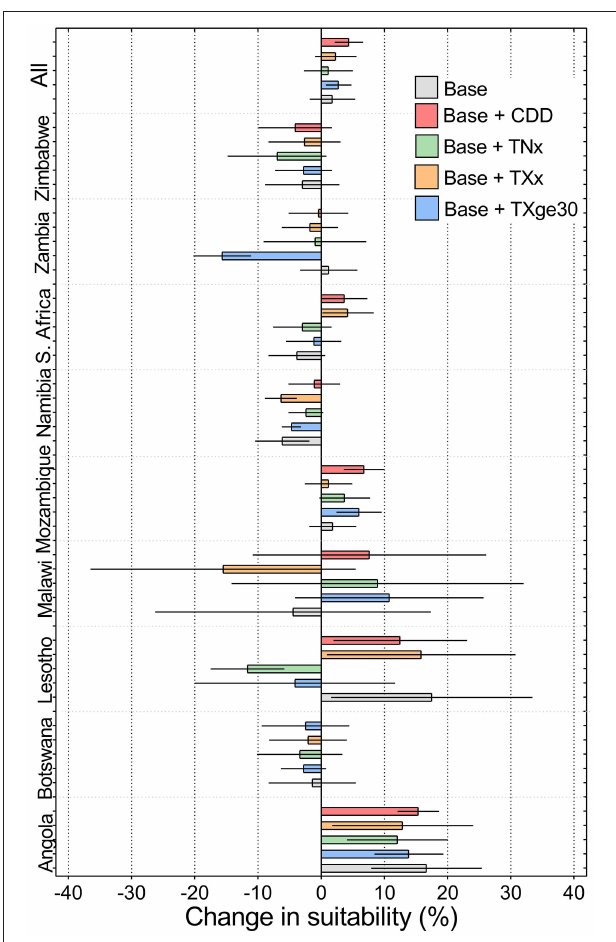
FIGURE 5 | Changes in maize suitability by around mid-century in individual countries and overall over Southern Africa from running the base models and including temperature and rainfall indices to the model. The base model has six agro-climatic indices while the other models have eight variables from adding the temperature sowing period and seasonal indices to the base variables. Eswatini was excluded as it had < 10 pixels. The error bars sow the results according to the 10 GCMs used. The changes are calculated as future suitability minus baseline suitability with positive values showing improved suitability and negative values showing decreases in maize suitability as averaged over the whole